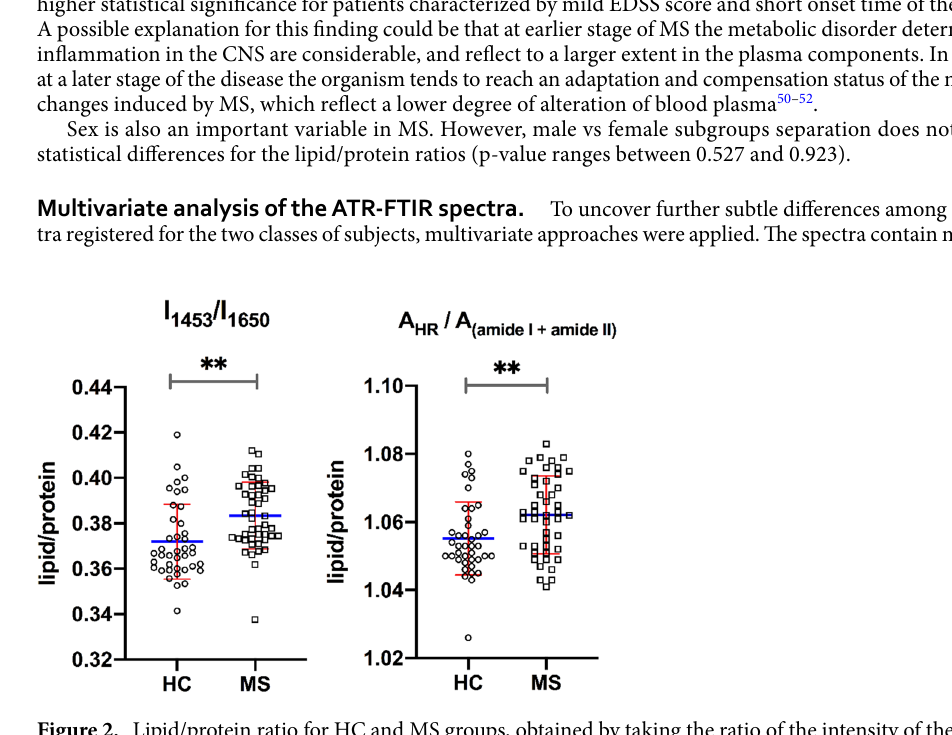
Figure 2. Lipid/protein ratio for HC and MS groups, obtained by taking the ratio of the intensity of the peaks at 1453 cm −1 to the amide I at 1650 cm −1 or the ratio of the areas under the high region (3050–2800 cm −1 ) and the sum under the amide I and amide II bands. The blue lines represent the mean values and the red lines the standard deviation. The degree of significance of the comparison between HC and MS is indicated as **p <